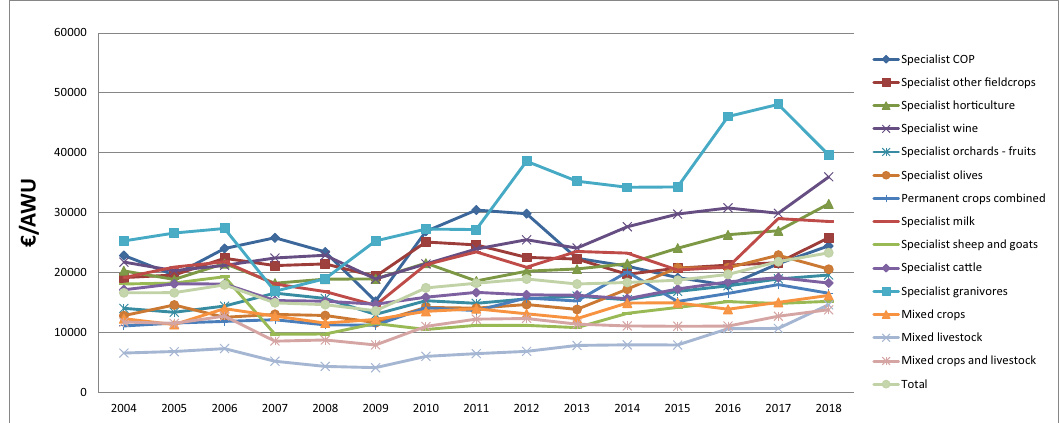
Figure 10: Farm net value added ( € /AWU ) , per farm, for several farm types, for the period 2004 – 2018.